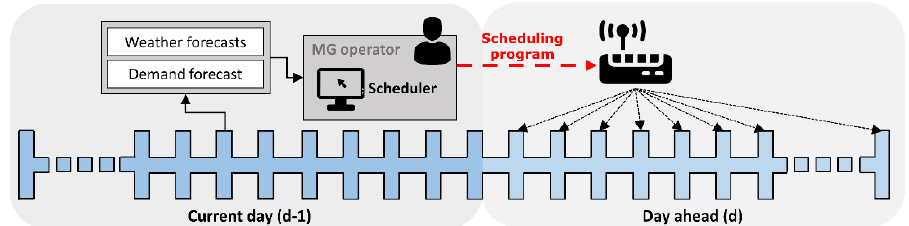
Figure 2. The day-ahead scheduling task for the MG under